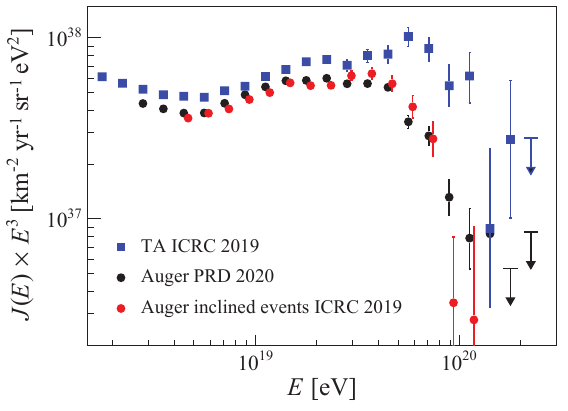
Figure 11. Auger energy spectrum obtained from the events in- clined at large zenith angles ( θ > 60 ◦ ) [24] compared with the measurements discussed in this